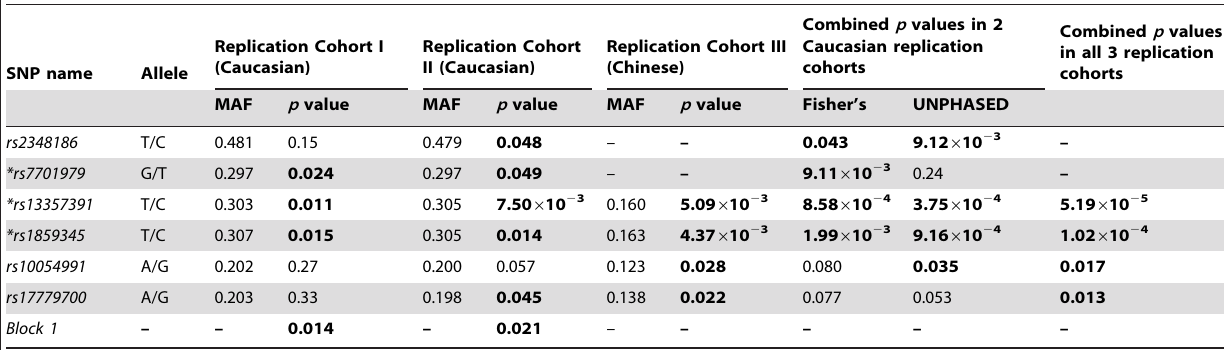
Table 3. Association signals of SNPs under replication.